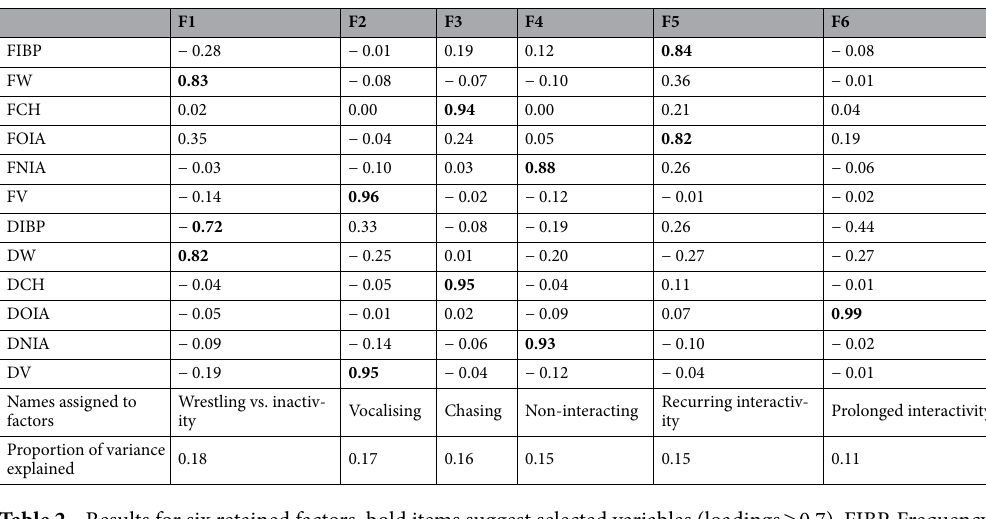
Table 2. Results for six retained factors, bold items suggest selected variables (loadings ≥ 0.7). FIBP, Frequency of Inactive body posture; FW, Frequency of Wrestling; FCH, Frequency of Chasing; FOIA, Frequency of Other interactive activities; FNIA, Frequency of Non-interactive activities; FV, Frequency of Vocalisation; DIBP, Duration of Inactive body posture; DW, Duration of Wrestling; DCH, Duration of Chasing; DOIA, Duration